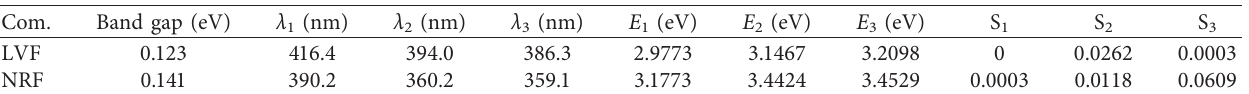
Figure 9: Total density matrix with electrostatic potential map (TDM-ESP) of (a) LVF and (b) NFX. Table 5: HOMO-LUMO energy band gap, UV/Vis. absorption wavelengths and corresponding oscillator strengths determined using TD-